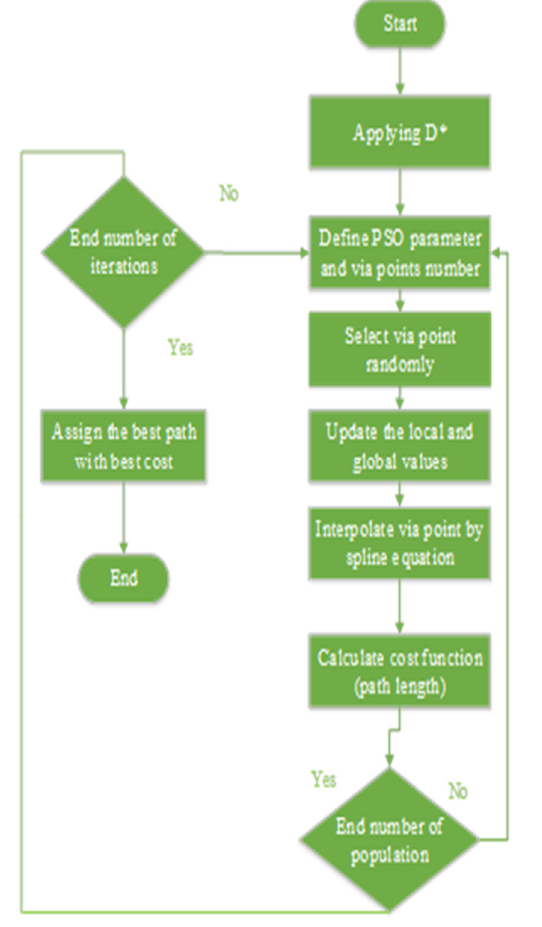
Fig. 5. Obstacle motion